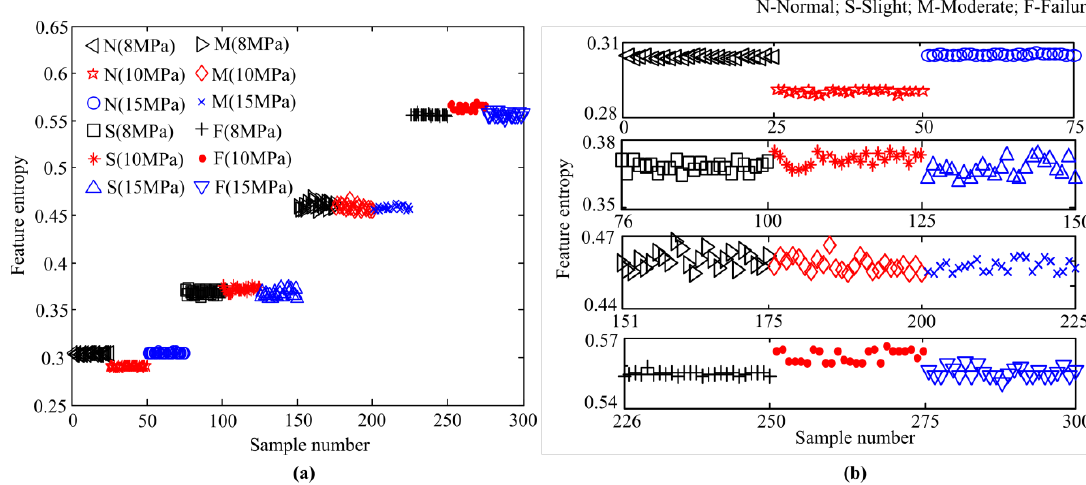
Figure 9. The local instantaneous energy moment entropy obtained from EMD3 under different working conditions: ( a ) All samples and ( b ) partially enlarged drawings.